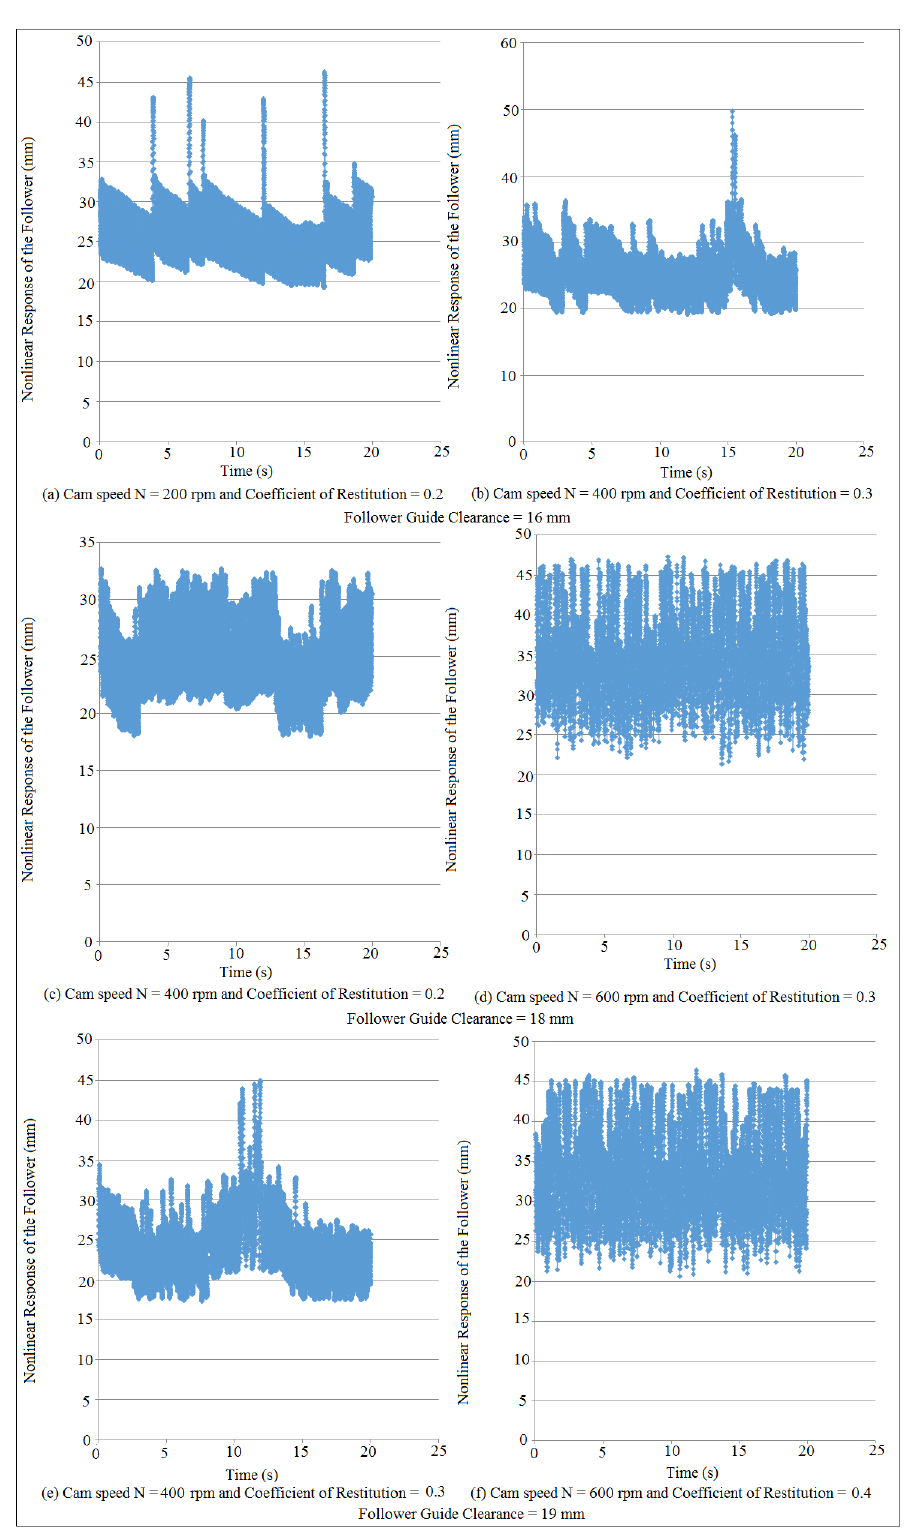
Figure 17. Nonlinear response mapping of the follower when the follower offsets to the left (O = 30 mm).